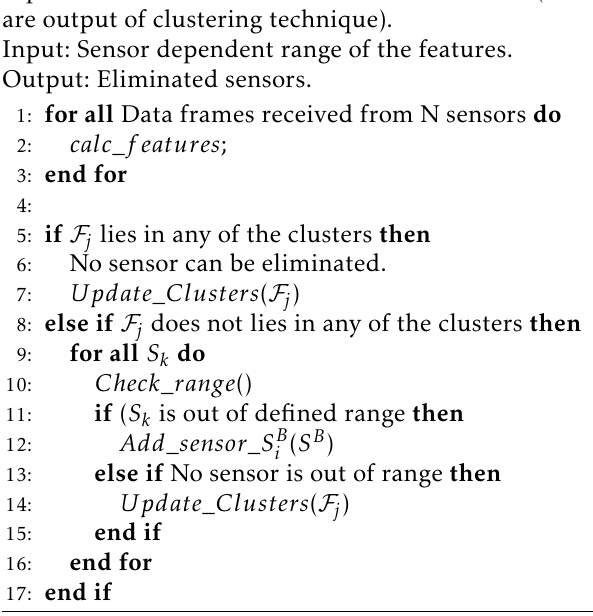
Algorithm 1 Algorithm for elimination of blinked